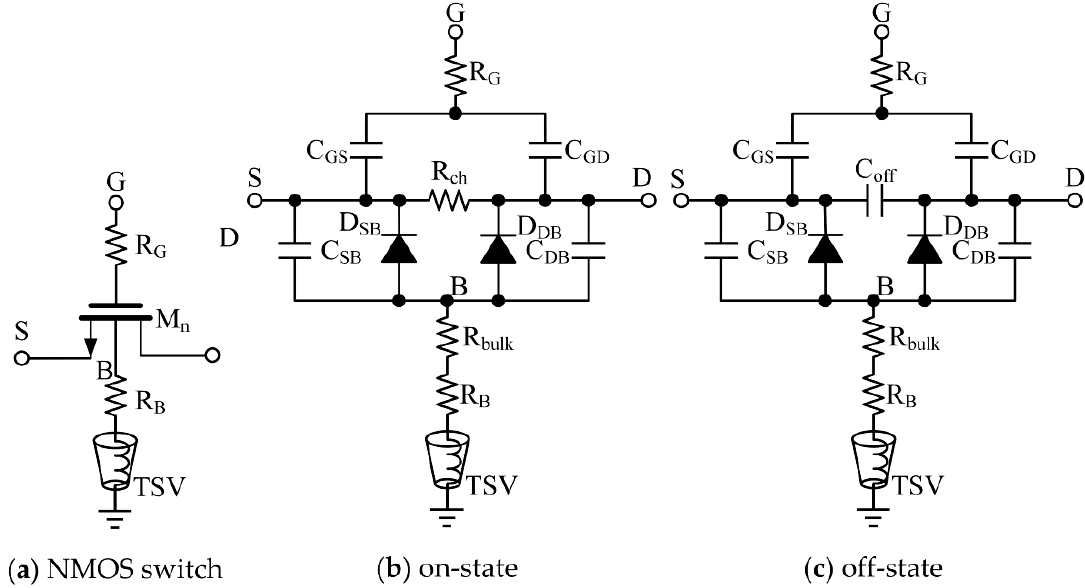
Figure 1. ( a ) The NMOS switch in the proposed attenuator; ( b ) The on-state simplified equivalent circuits of the switch; ( c ) The off-state simplified equivalent circuits of the switch.